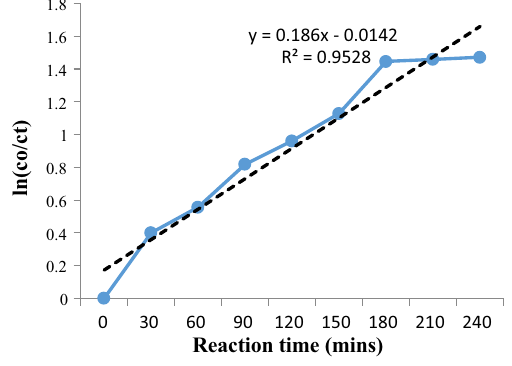
y = 0.1447x + 0.1111 R² = 0.9041